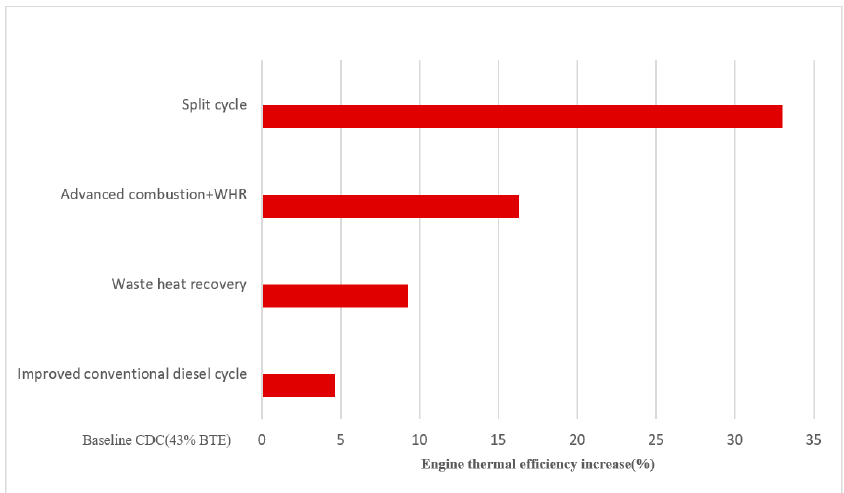
Figure 23. Potential increase in brake thermal efficiency of various engine technologies [7,20].